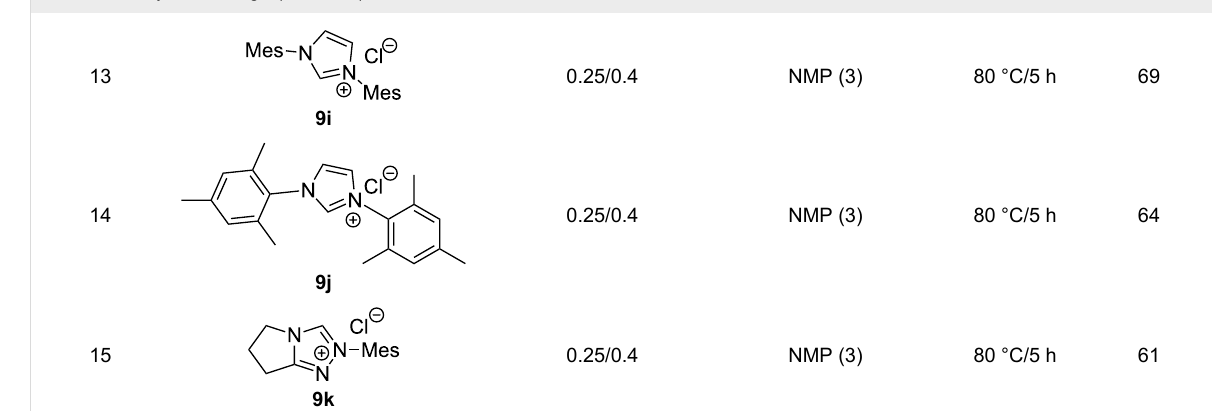
Table 1: Catalyst screening. a (continued)